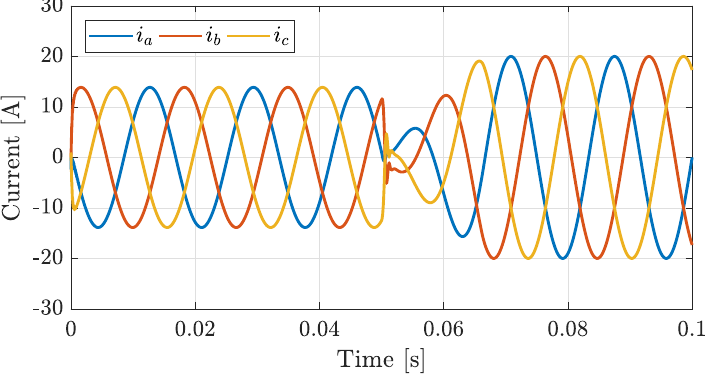
Figure 7. Simulation of three controllers designed to face a balanced linear loads interaction.